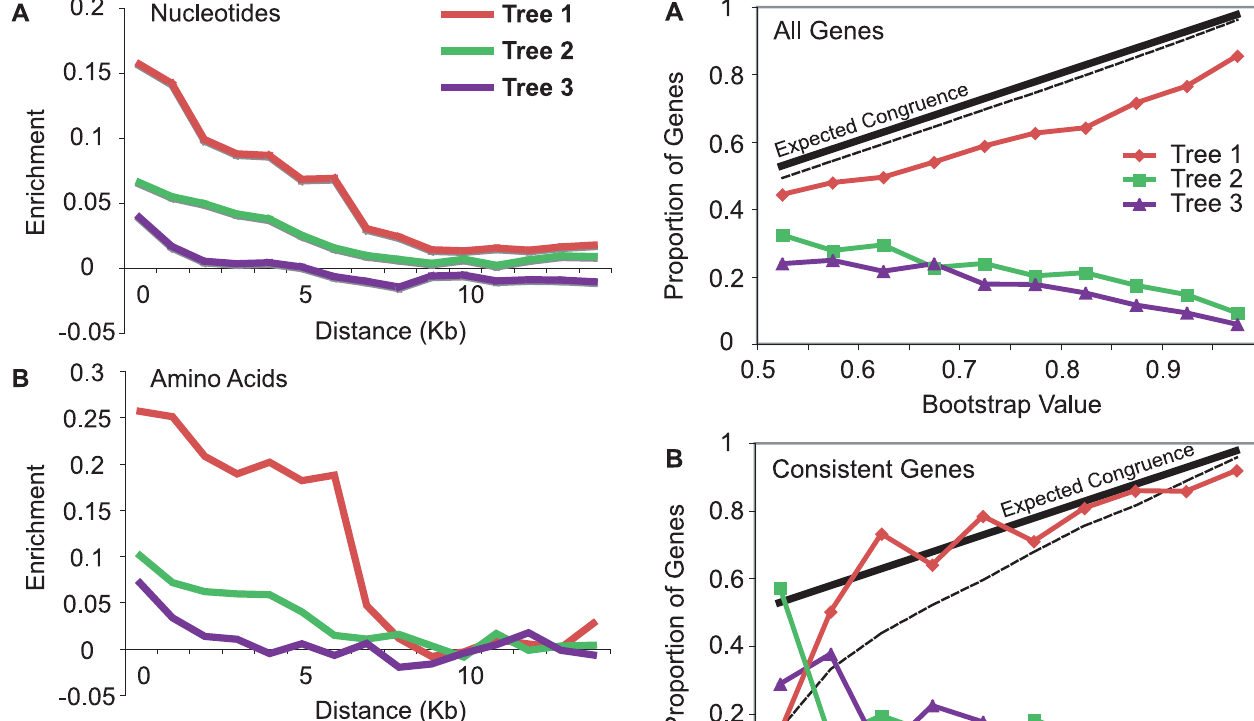
Figure 6. Clustering of Informative Sites The enrichment of informative nucleotide (A) and amino acid (B) substitutions near other substitutions that support the same phylogeny was found for all three trees and is on a scale roughly similar to estimates of linkage disequilibrium. At each informative site in the genome, the counts of informative sites supporting each of the three trees in 1-kb windows extending 30 kb up- and downstream were measured. For each type of informative site, the enrichment of the same type of informative site in each 1-kb window was calculated using the observed counts and the expected number of sites based on their genome-wide frequency. Enrichment is log 10 (observed / expected).